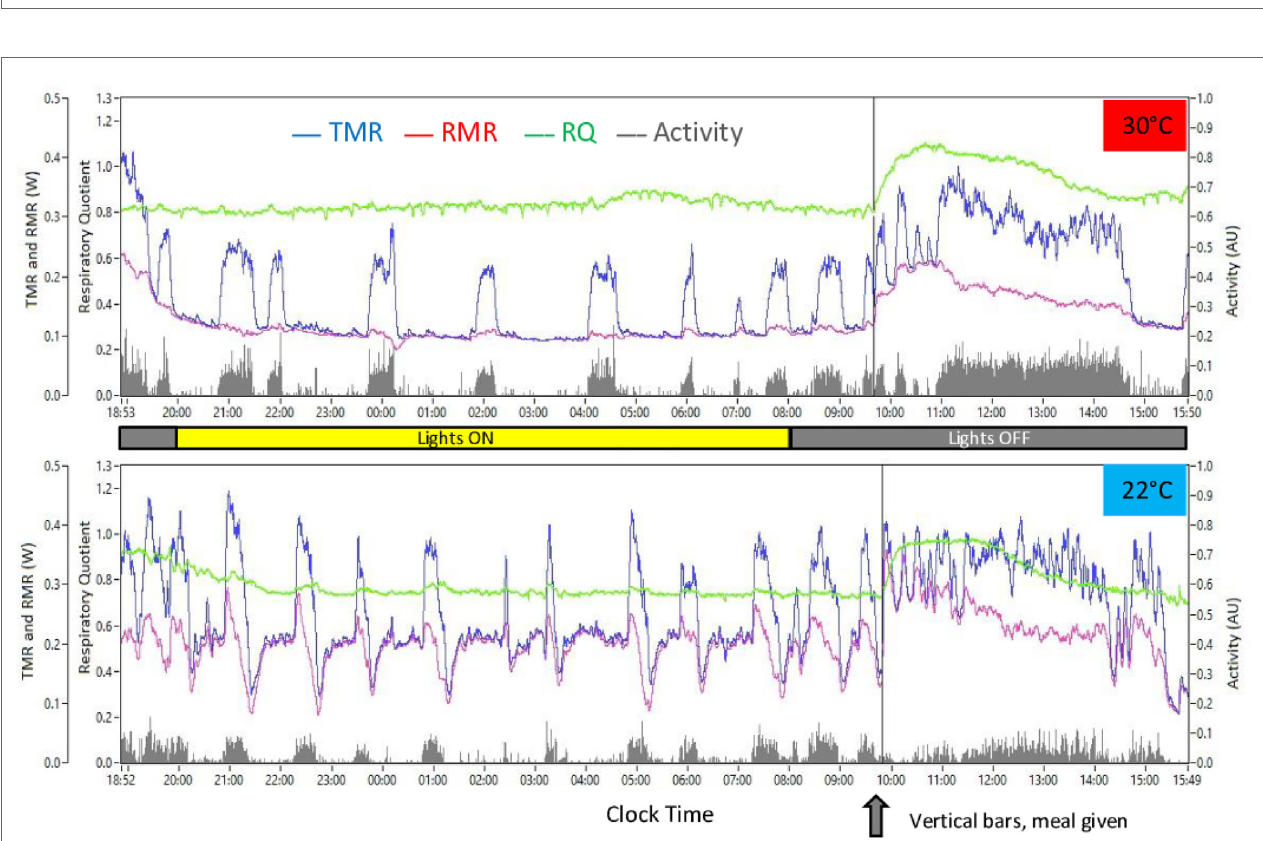
FigUre 2 | example of calculation of activity cost and rMr in mice under ad libitum conditions . Data were obtained from the multiplexed device. Acquisition was at 10 min intervals. (a) Changes in activity, TMR and RMR measured along the time. The original activity trace was slightly smoothed to better correlate with TMR. (B) Correlation between intensity of activity and TMR. Slope of the regression gives the cost of activity and origin gives RMR. RMR in (a) was computed as TMR (activity ×